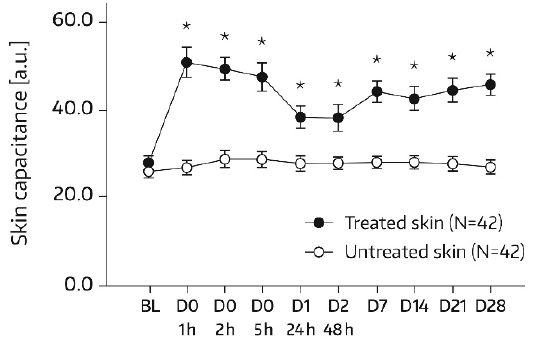
Figure 5. Results from skin capacitance measurements in untreated skin and skin undergoing a single application of Emollient 2 (first 48 h) followed by once-daily application for 26 days. The values were assessed by corneometry and are presented as mean ± SD. BL = Baseline skin capacitance value before first product application; D = day; h = hour. * p < 0.001 if compared to untreated control, paired t -test.